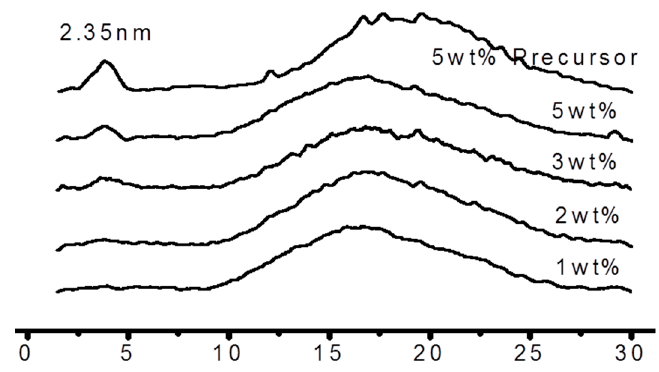
Figure 4. XRD curves of D-clay epoxy at different weight loadings.